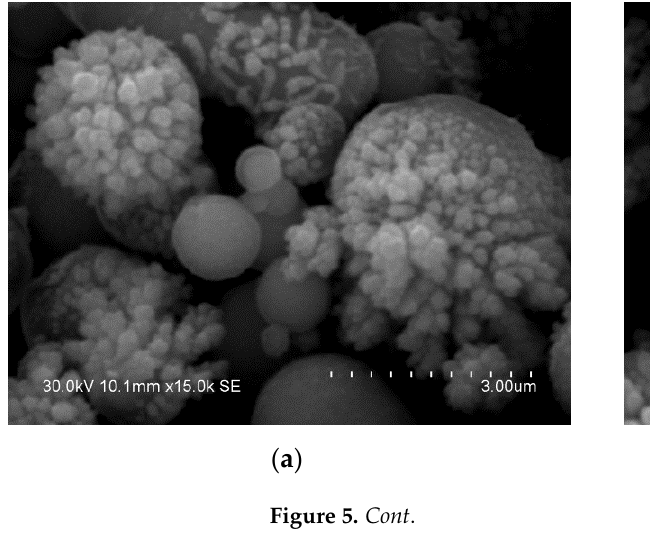
Figure 4. XRD pattern of the Fe@Pd core–shell particles obtained by galvanic replacement reaction. The electron microscopy images of the product of galvanic replacement show that a layer is formed on the surface of the iron particles (Figure 5a,b). This layer consists of separate submicron particles. The product of galvanic replacement is Fe@Pd core–shell particles, in which the core is Fe-based and the shell is Pd-based. It should be noted that some shells are not continuous and have orifices in them, which is typical for particles obtained by this method. The EDS analysis (Figure 5c) shows that the Fe/Pd atomic ratio in the product of galvanic replacement is close to 4:1, which indicates a nearly full reduc- tion of palladium ions present in the solution by metallic iron. In Figure 5d, cross-sections of the core–shell particles are shown. The presence of shell is clearly visible in the image. In the Mössbauer spectrum of the core–shell particles, two sextets are present corre- sponding to α -Fe (green line) and α -Fe with a “disordered” structure (blue line), as dis- cussed in Section 3.1 (Figure 6). In addition, a doublet is present (red line), which can be related to the presence of Fe 3+ . The presence of this doublet can be due to the formation of a small amount of the oxide phase during the preparation of the sample. A similar effect was earlier observed in ref. [34].